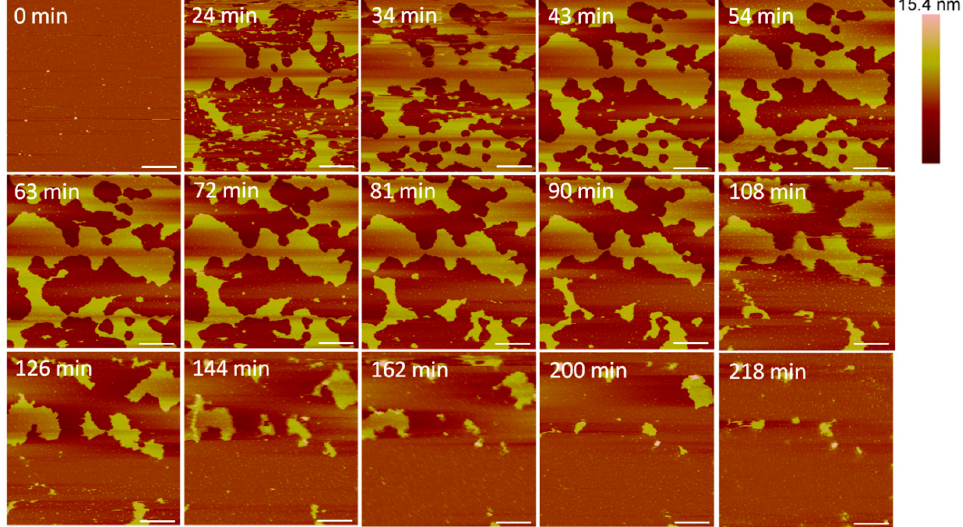
Figure 3 . Defects formed in a supported PC bilayer after injection of 5 µM alamethicin over 218 min. Each AFM image was scanned in the same location on the substrate. The scale bars represent a distance of 1 µm.